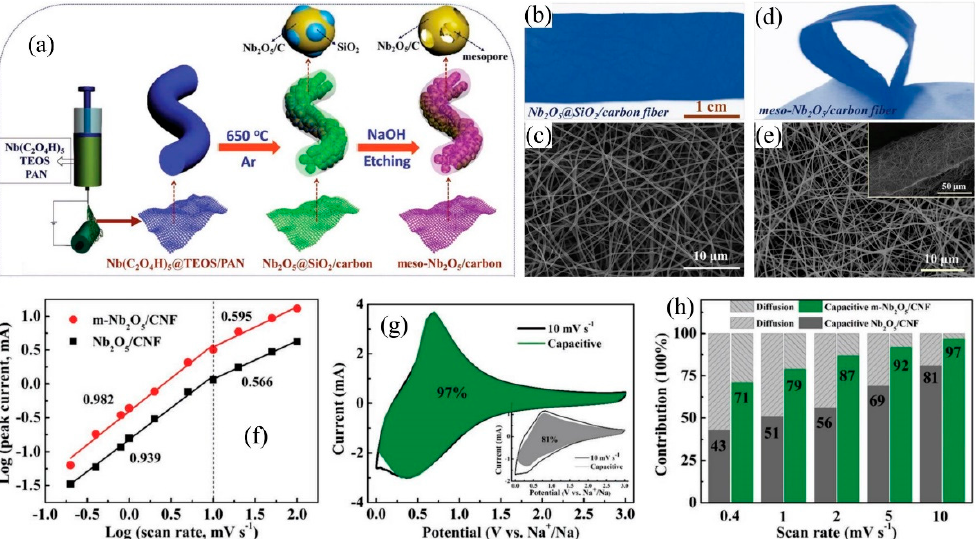
Figure 8. ( a ) Schematic illustration of the fabrication of flexible m-Nb 2 O 5 /CNF films. Photograph and SEM images of ( b , c ) Nb 2 O 5 /SiO 2 /CNF and ( d , e ) m-Nb 2 O 5 /CNF. ( f ) The relationship between peak currents and scan rates of m-Nb 2 O 5 /CNF and Nb 2 O 5 /CNF. ( g ) Capacitive contribution curves of m-Nb 2 O 5 /CNF at 10 mV s − 1 . ( h ) Normalized ratio for m-Nb 2 O 5 /CNF and Nb 2 O 5 /CNF at different scan rates. Reproduced with permission from Ref. [86] Copyright 2019 Wiley.